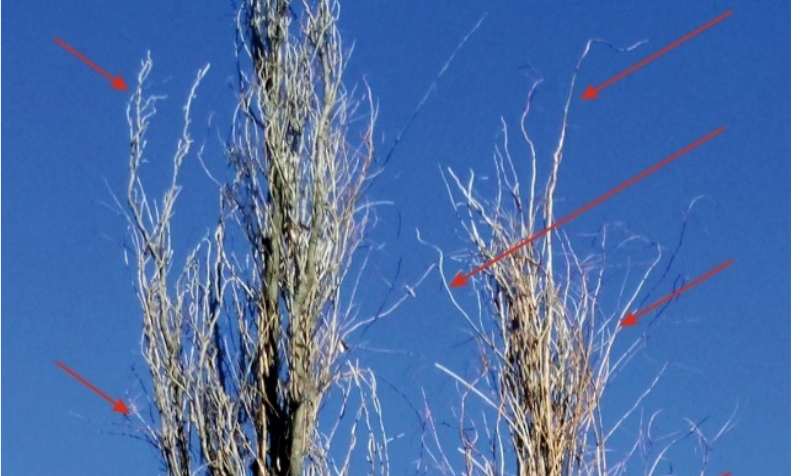
Figure 4. Annual freezing of shoots of Robinia pseudoacacia f. pyramidalis by 25–50% of the length of annual growth (Volgograd, seed plantations of the Federal Research Center of Agroecology of the Russian Academy of Sciences). Red arrows mean dry shoots as a result of freezing.